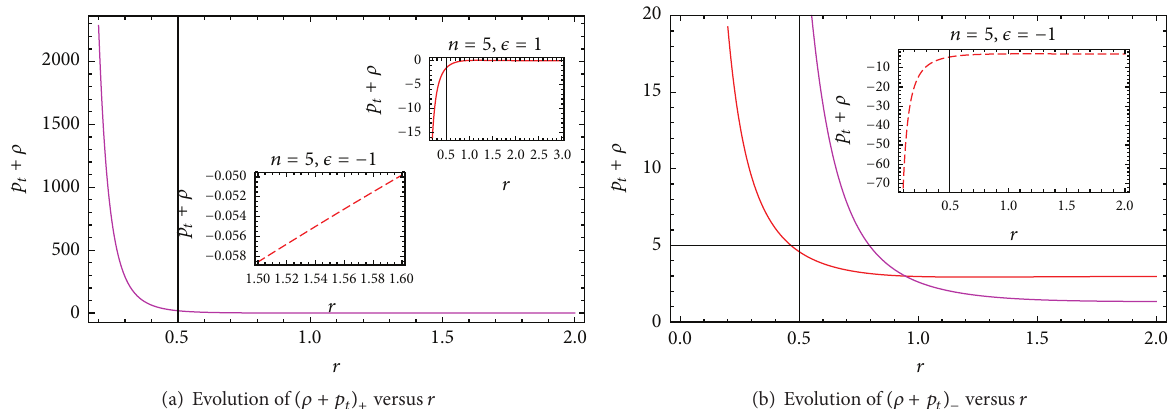
Figure 8: Plots of (a) 𝜌 + 𝑝 𝑡 for 𝑠 + and (b) 𝜌 + 𝑝 𝑡 for 𝑠 − versus 𝑟 in Lorentzian distribution for 𝑛 = 5 , 𝜖 = 1 (red), 𝑛 = 5 , 𝜖 = −1 (red dashed), and 𝑛 = 6 , 𝜖 = 3 (purple).